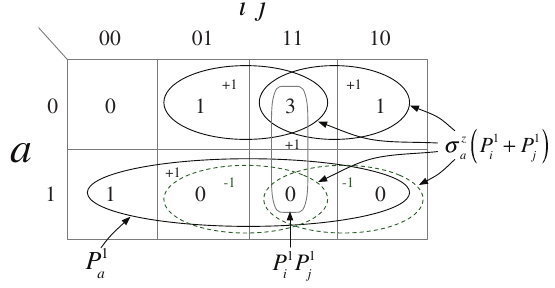
FIG. 14. Penalties from Table I appear here as nonzero values in the center of the cells, which will be multiplied by Q . Contribu- tions are shown as ovals with + 1 or − 1 indicating the coefficient for the contribution. The sum of such values for all ovals cover- ing the center of a cell totals to the penalty value of the cell. When + P 1 generates the two ovals in the restricted to the first row, P 1 i j row. The same contribution with the opposite phase is needed in (cid:23) (cid:24) + P 1 the bottom row, shown with green dashed ovals. σ z P 1 a i j generates all four contributions. A value of 1 is added in the bot- , leaving only cell 1/11 needing a correction, tom row with P 1 a . This process leaves cell 0/11 with a which is provided by P 1 P 1 i j larger than needed but acceptable penalty of 3 Q